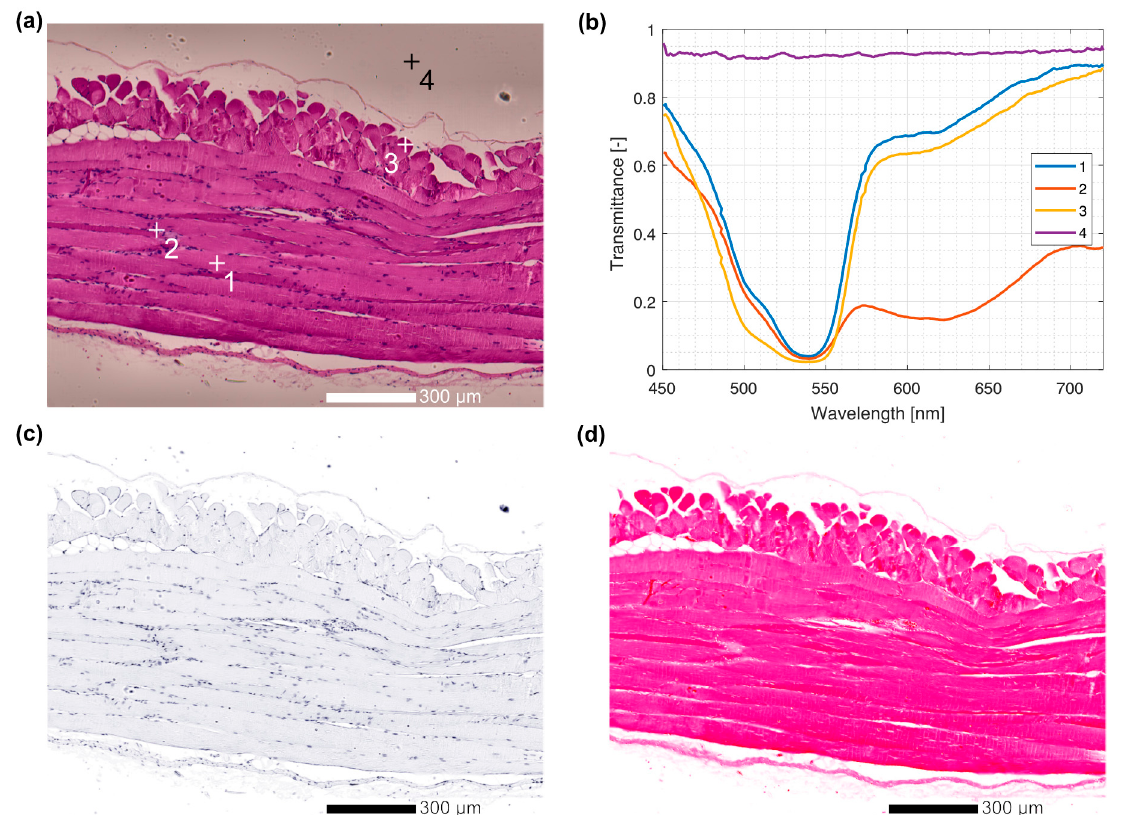
Figure 8. A hematoxylin and eosin-stained histology slide of a healthy murine abdominal wall at 10× magnification recorded by HMI. ( a ). An RGB image reconstructed from the HMI data. Spectra were selected at different image points and marked by + signs and labeled by numbers. ( b ). Spectra corresponding to the marked image points. Based on the spectra, individual hematoxylin and eosin maps were calculated using a Beer–Lamber attenuation law and presented in false color (( c )—hematoxylin, ( d )—eosin).